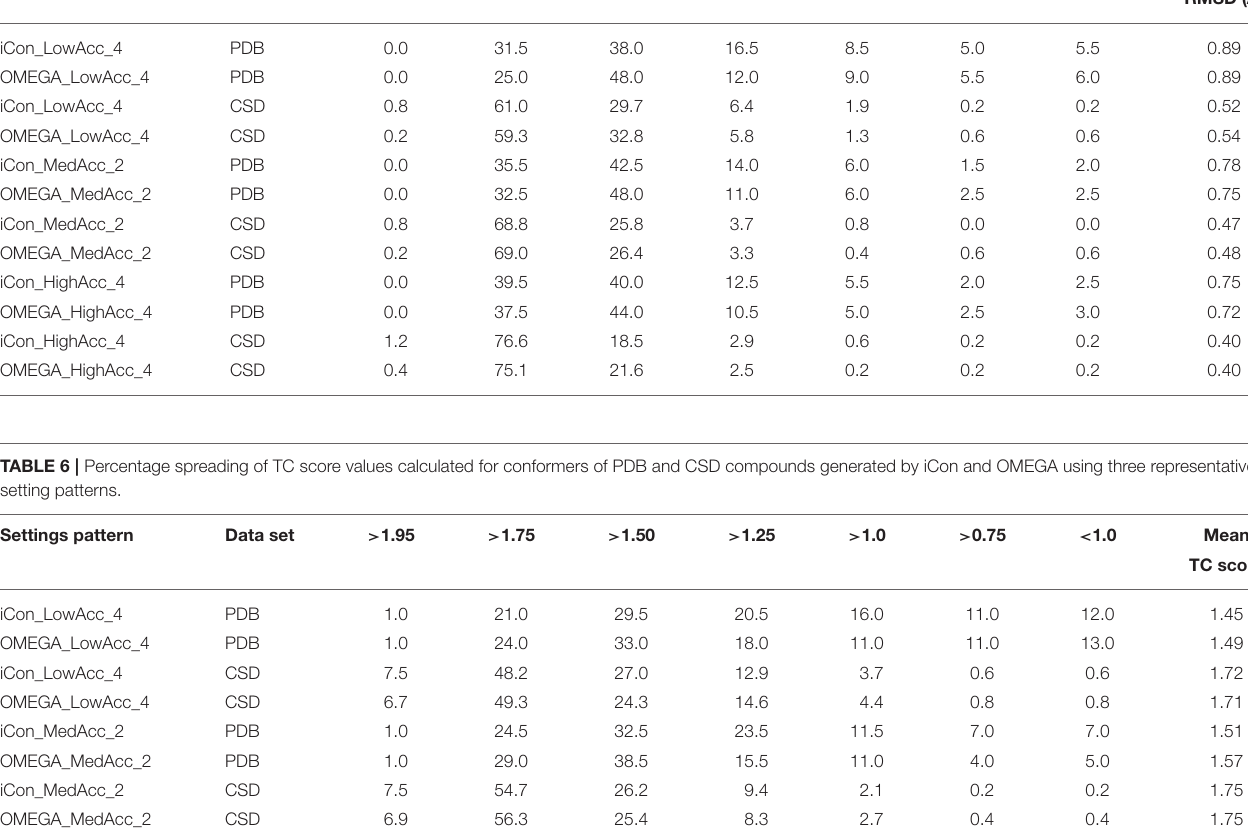
TABLE 5 | Percentage spreading of RMSD values calculated for conformers of PDB and CSD compounds generated by iCon and OMEGA using three representative setting patterns. Setting pattern